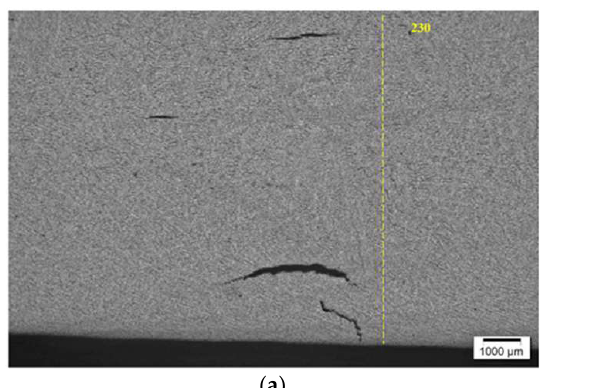
Figure 29. Section No4: 142–198. Coordinate 190 mm. Magnification 12.5× ( a ), 6.1–6.5 mm from ID, stepwise cracking magnification 50× ( b ).